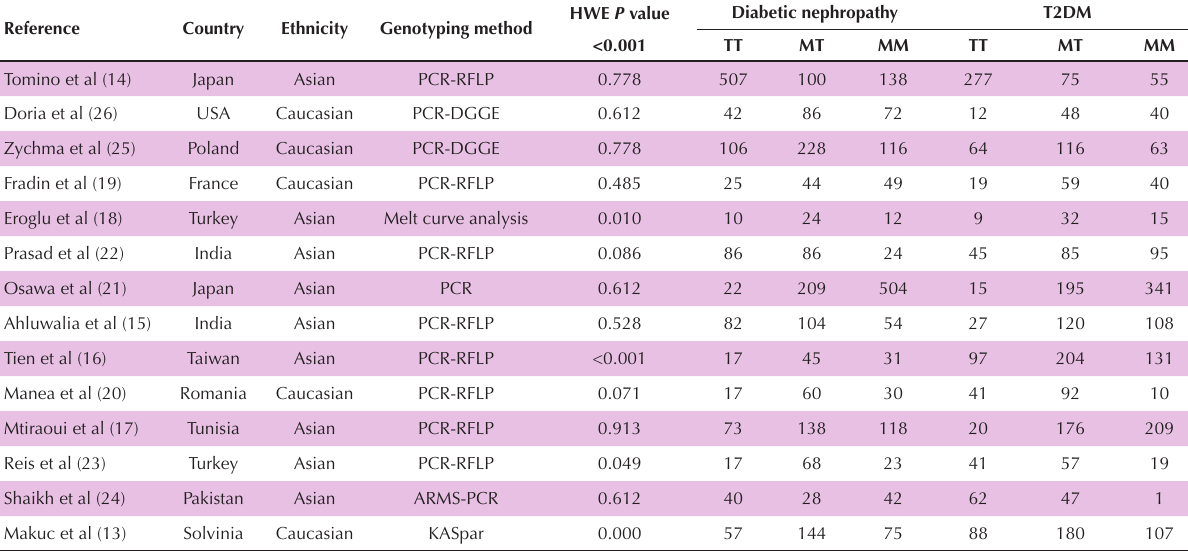
Table 1. Baseline characteristics of the AGT M235T studies included in the meta-analysis Reference